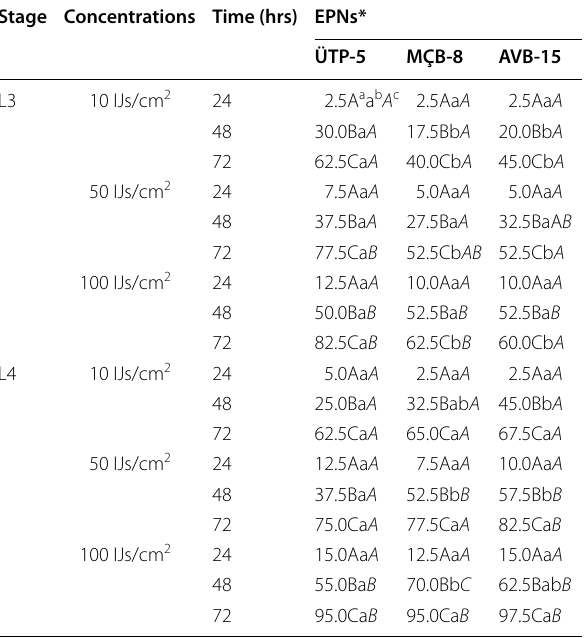
Table 3 The efficacy of infective juveniles of different entomopathogenic nematodes against 3rd and 4th instar Agrotis segetum larvae at the 1st, 2nd, and 3rd day after treatment (DAT) under laboratory conditions (25 1 °C, R.H. ±